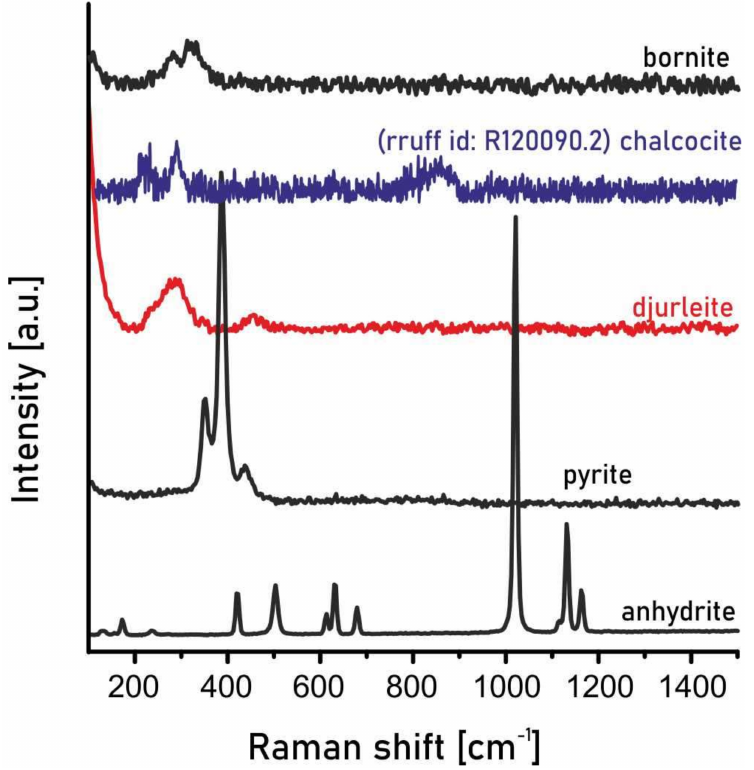
Figure 4. Raman shifts of all minerals from the investigated sample from the Lubin mine, Poland. A basic chalcocite standard is added for